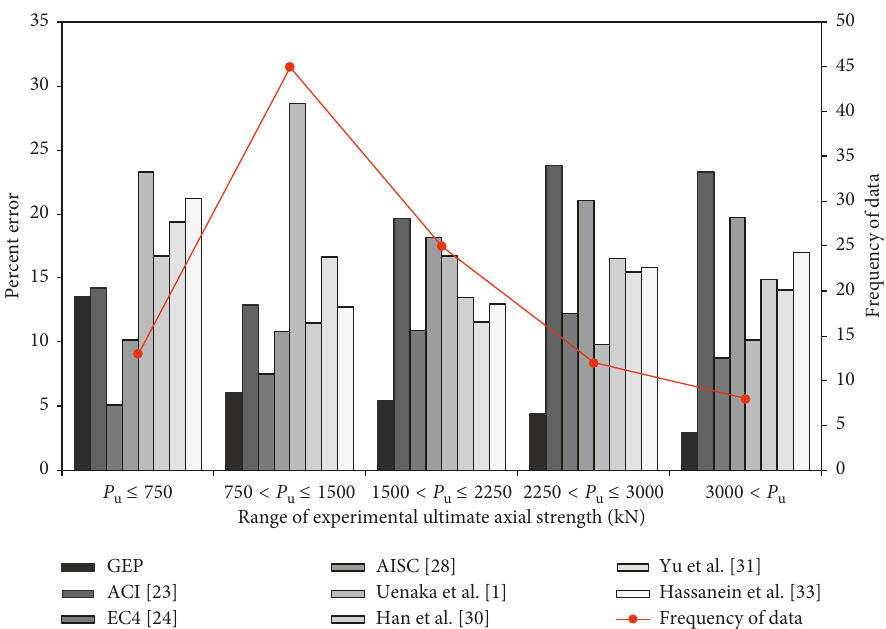
Figure 7: Error analysis of the proposed and existing models.